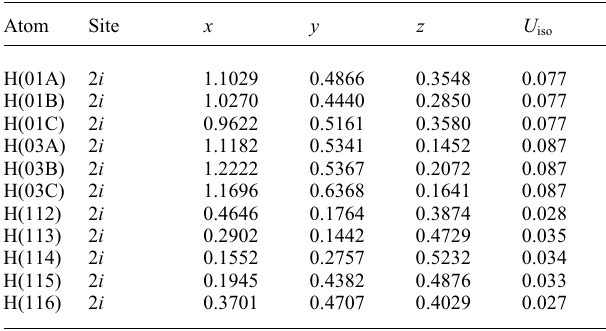
Table 2. Atomic coordinates and displacement parameters (in Å 2 )